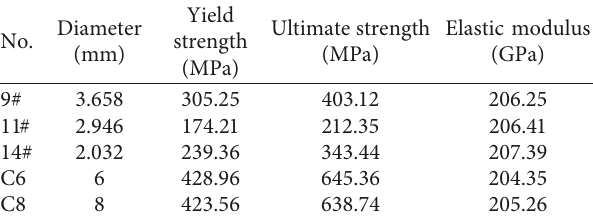
Table 2: Mechanical properties of the reinforcement